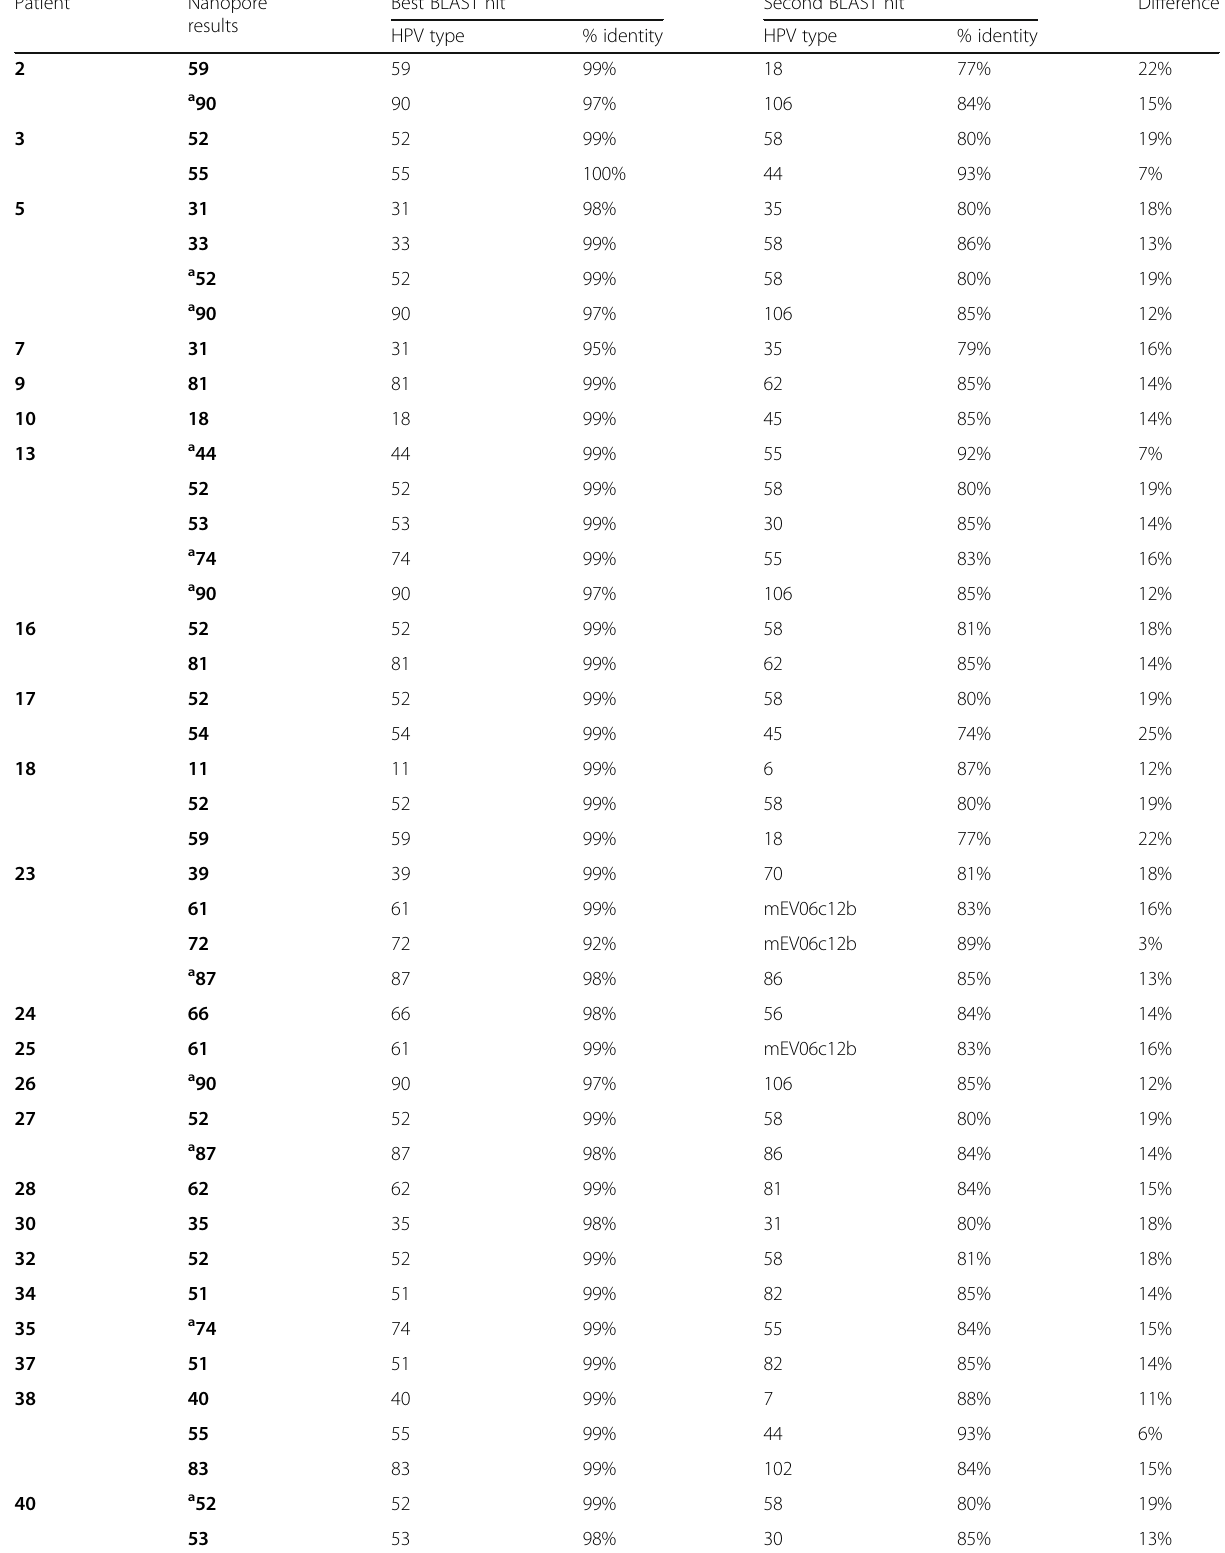
Table 7 Percentage of identity of Nanopore consensus sequences to HPV reference genomes